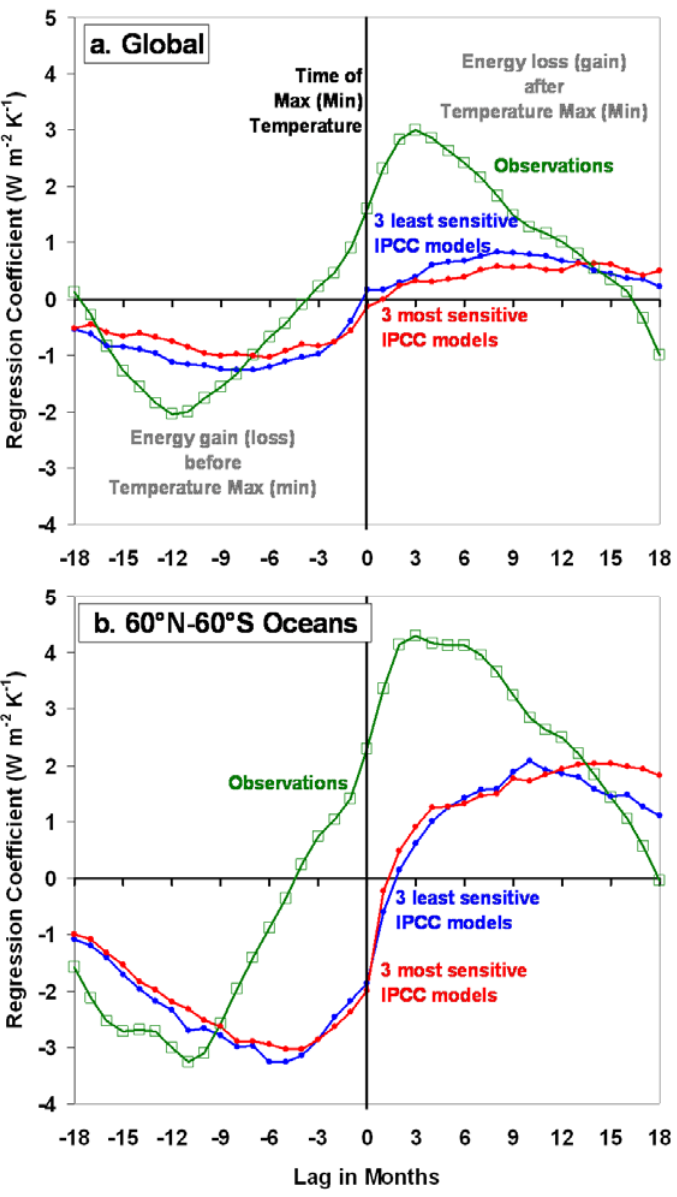
Figure 3. Lead and lag regression coefficients between monthly surface temperature anomalies and Net radiative flux anomalies in observations versus coupled climate models for: (a) global averages, and (b) global ocean averages, 60°N to